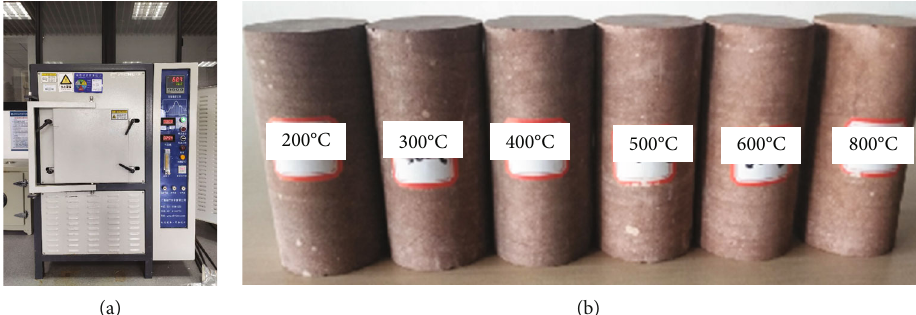
Figure 1: Specimen preparation. (a) The high-temperature furnace. (b) The red sandstone specimens after high-temperature exposure.